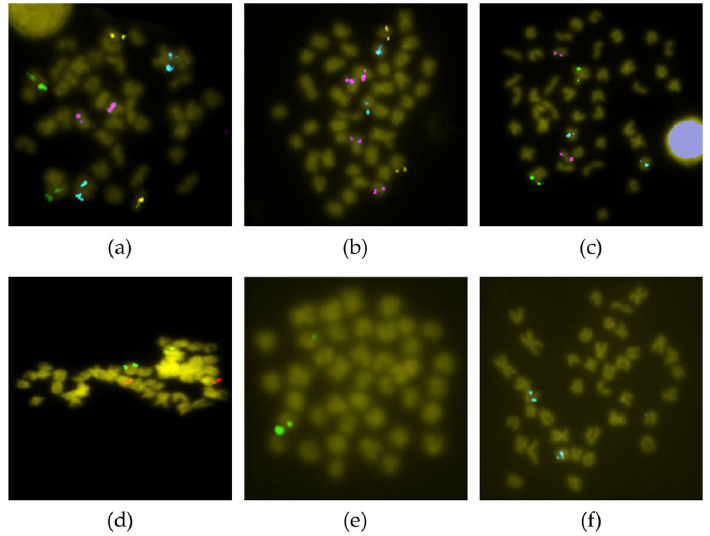
Figure 3. BAC-FISH with probes not assigned to a particular chromosome. ( a ) 54F6 (green)—45M23 (yellow)—53I12 (pink)—73B7 (cyan); ( b ) 73J17 (green)—46K16 (yellow)—53I12 (pink)—68G4 (cyan); ( c ) 73B7 (green)—57G6 (pink)—54F6 (cyan); ( d ) 71J13 (green)—53I12 (red); ( e ) 60P24 (green); ( f ) 59B23 (cyan).